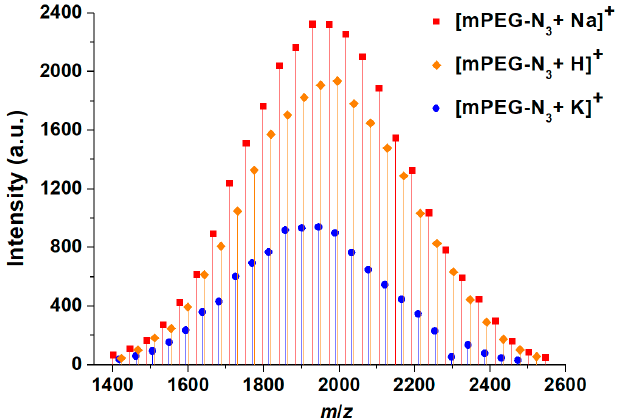
Figure 2. MALDI-TOF mass spectrum of mPEG 2000 -N 3 adduct distributions.